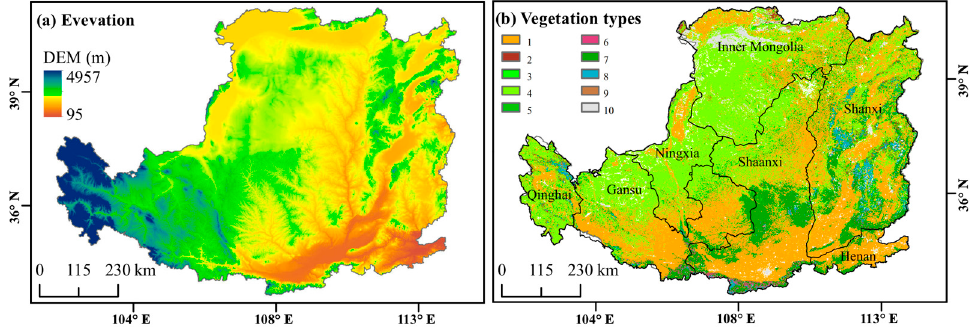
Figure 1. Vegetation types and elevation maps of the Loess Plateau. 1. Crop, 2. mosaic grass, 3. shrub, 4. grassland, 5. mosiac tree, 6. evergreen broadleaf forest, 7. deciduous broadleaf forest, 8. evergreen needleleaf forest, 9. evergreen broadleaf forest, 10.